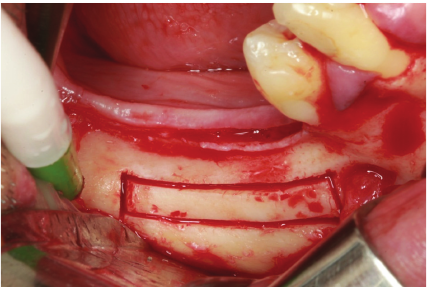
Figure 28: Traction beam performed with latex.